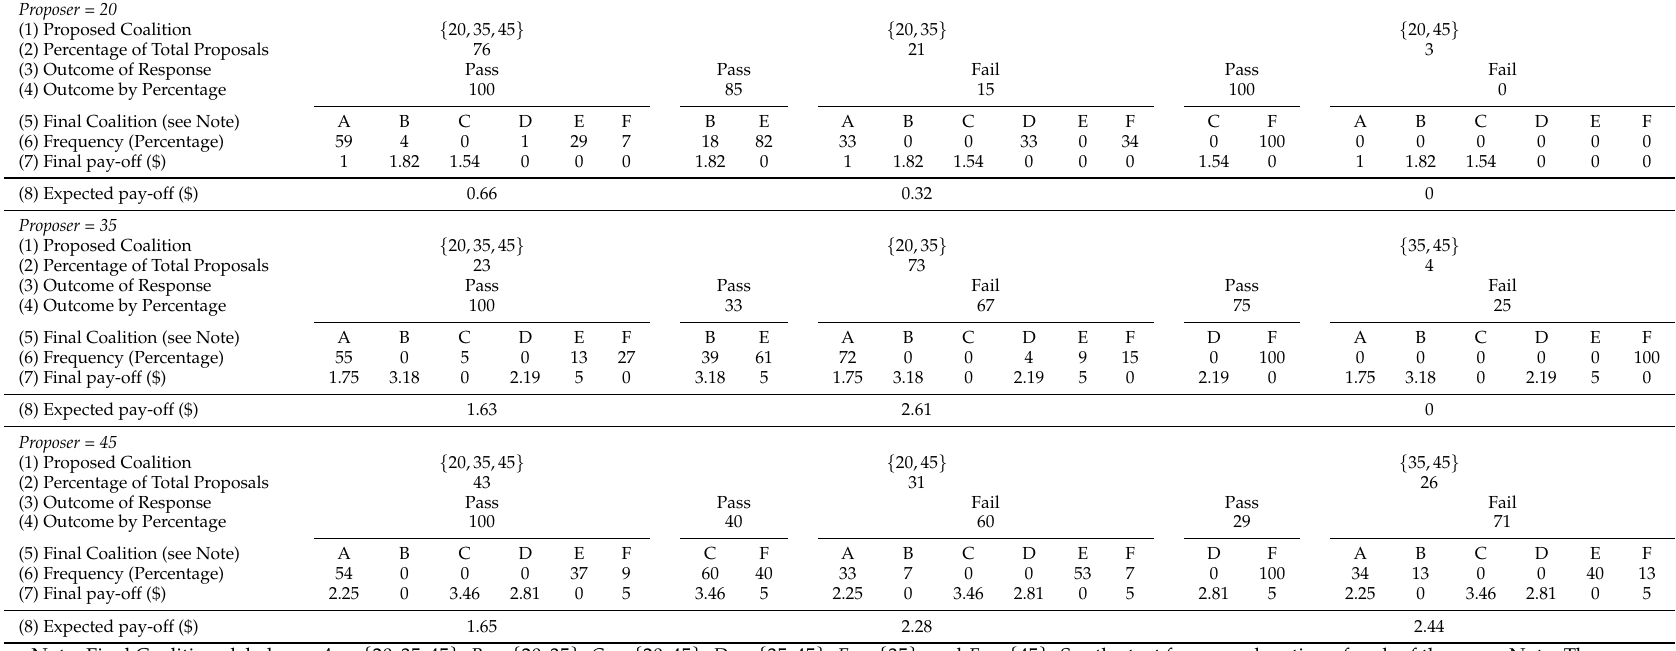
Table A3. Expected payoffs by proposal strategy for each power draw, late